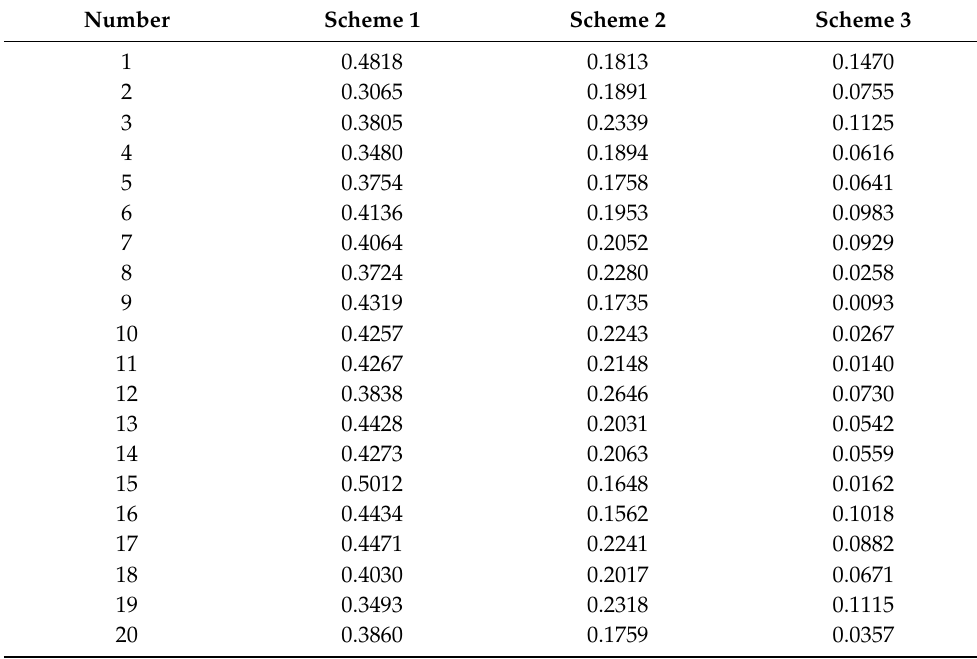
Table 2. The MAEs of position errors (m) in the 20 experiment